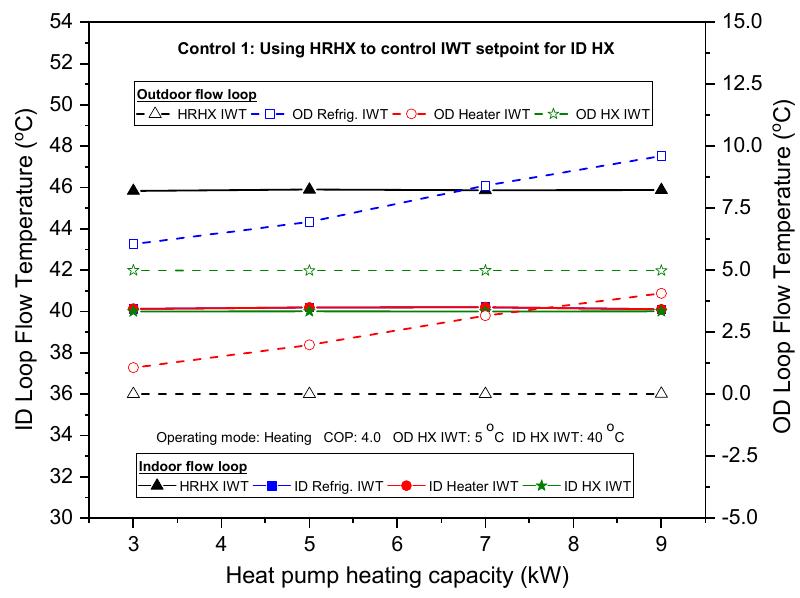
Figure 3. Flow loop temperature with variation in heat pump heating capacity for control (1).